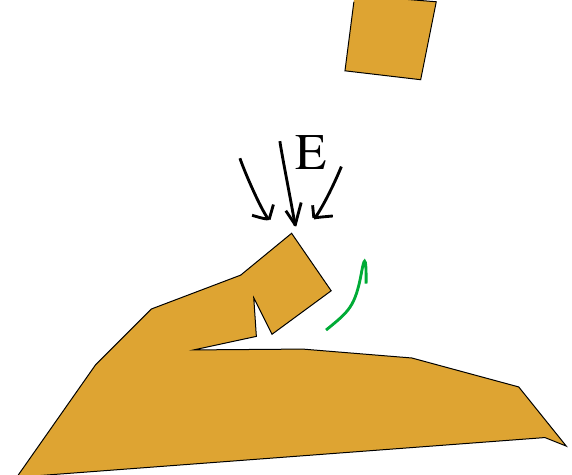
FIG. 37. (Color) Mechanical breakup of an emitter with one fragment gone and another in the process of breaking